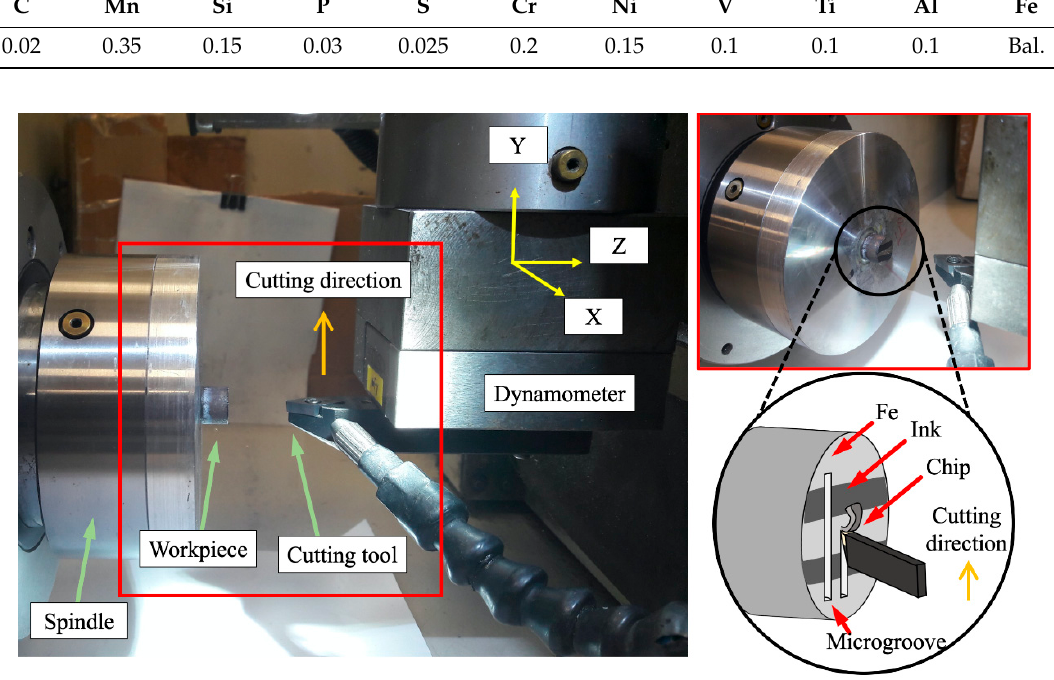
Figure 1. Experimental setup and the schematic for microcutting experiments. Table 2. Diamond tool wear mitigation techniques to machine ferrous metals.